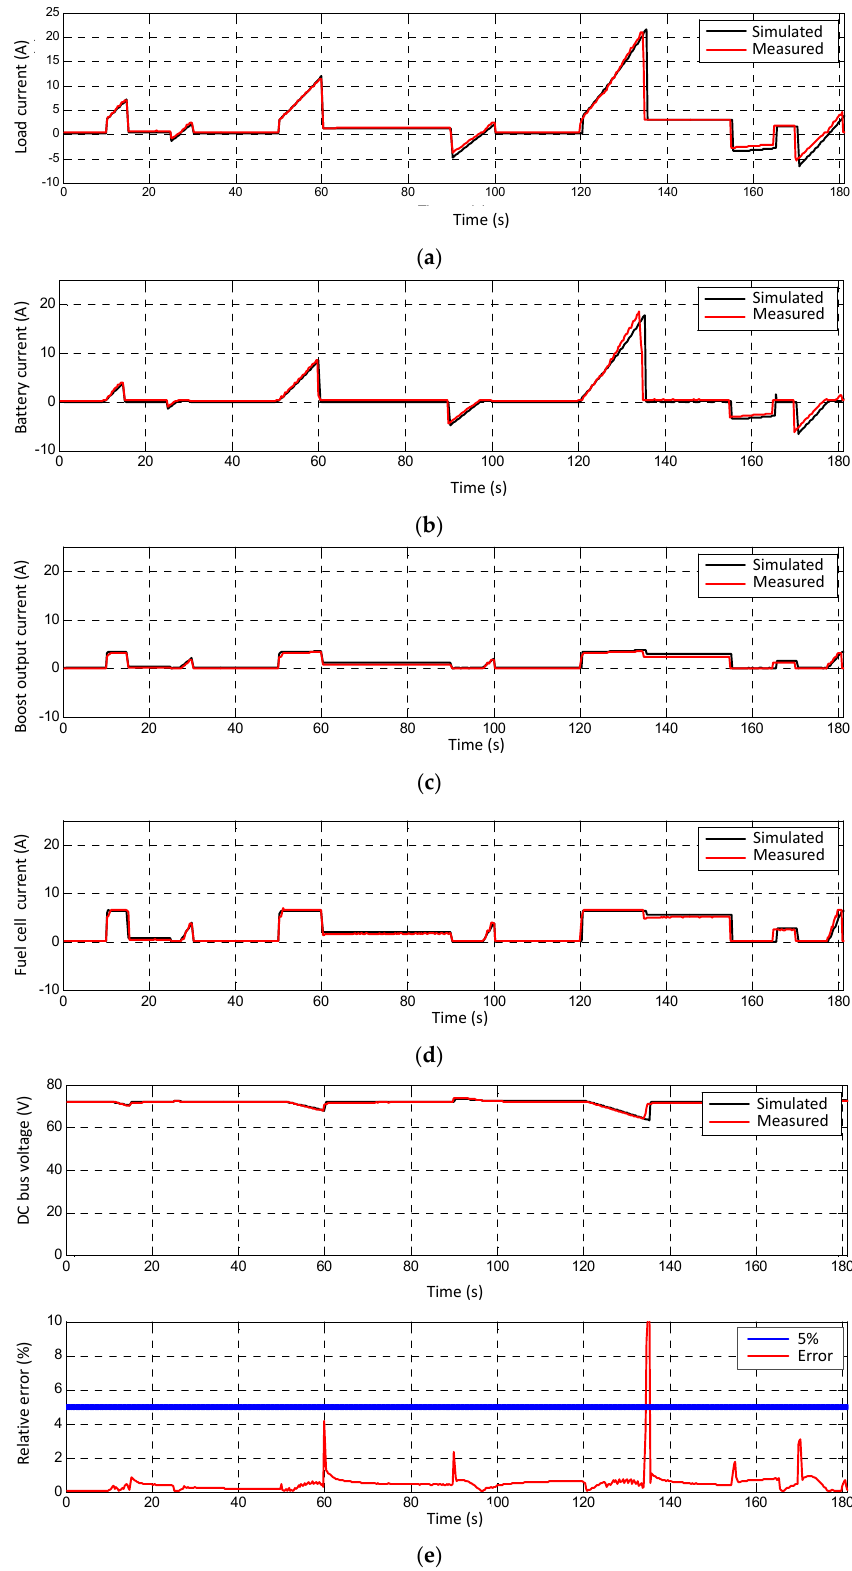
Figure 30. Comparison between simulated and measured results of the system main magnitudes: ( a ) Load current. ( b ) Battery current. ( c ) DC-DC power converter output current. ( d ) Fuel cell output current. ( e ) DC bus voltage and its relative error.